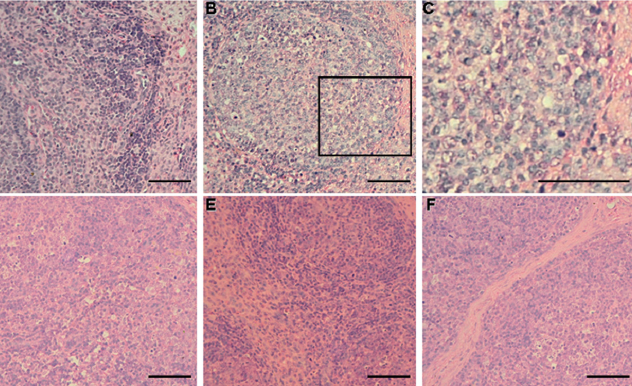
Fig 4. Histopathologic changes in the inguinal lymph nodes of rFla-Cap vaccinated pigs after PCV2 challenge. (A) Inguinal lymph node section from a non-vaccinated non-challenged pig shows no noticeable microscopic lesions. (B) Severe microscopic lesions of lymph nodes from a non-vaccinated PCV2-challenged pig. Depletion of lymphocytes, infiltration of histiocytes, and syncytial cells were seen. (C) Enlargement of some areas (black square) in panel B. No or mild microscopic lesions were seen in the lymph node of a 200rFla-Cap-vaccinated PCV2-challenged (D) or Sub-Vac-vaccinated PCV2-challenged (F) pig. (E) No noticeable lesions were seen in the lymph node of a 500rFla-Cap-vaccinated PCV2-challenged pig. Bar, 80 μ m.